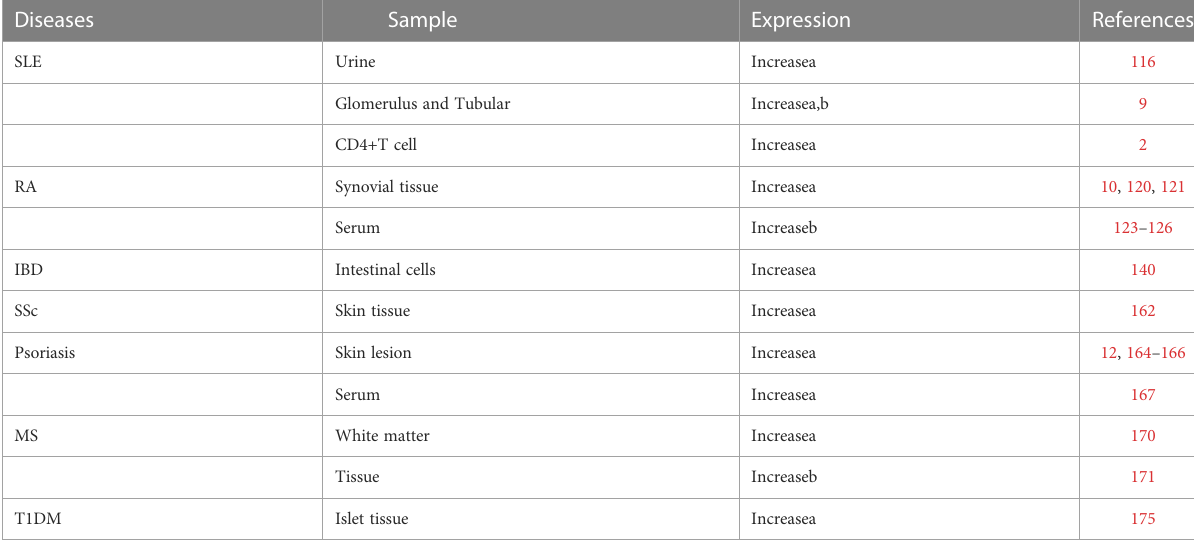
TABLE 1 Expression of HIF-1 ɑ in in fl ammatory autoimmune